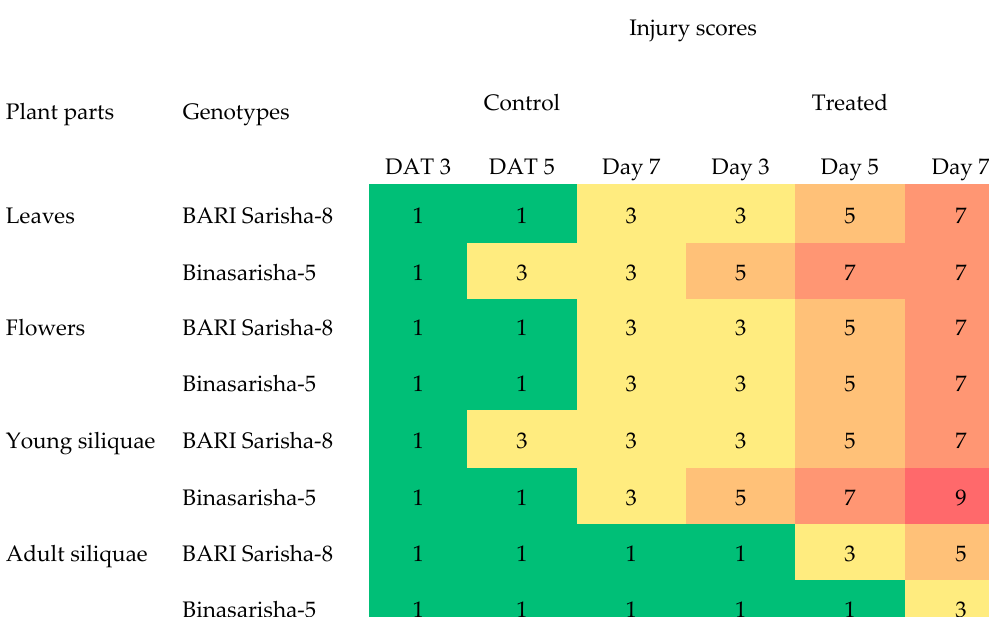
Figure 5. Injury scoring of two rapeseed genotypes, under control and 100 mM NaCl treated conditions at the reproductive stage, in a heat map created using conditional formatting in Microsoft Excel (Supplementary Datasheet 1). DAT, days after treatment. Each data point is the median value of five independent observations. Green, yellow, and red colors represent no, moderate, and severe injury levels.